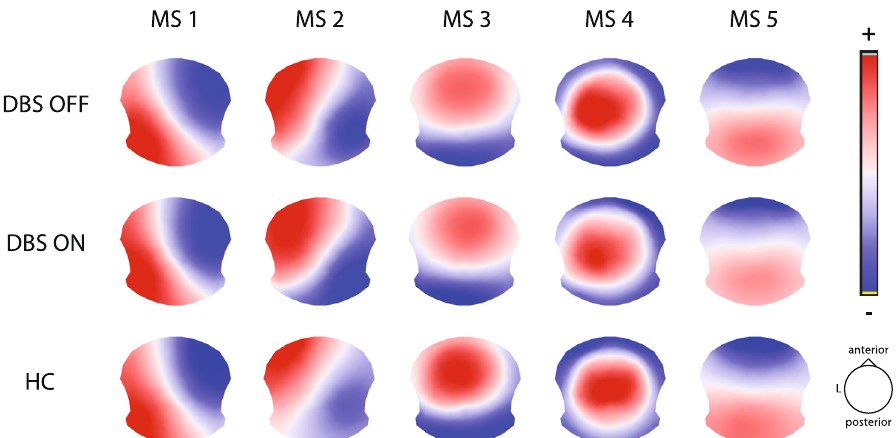
Fig. 1 Topographies of fi ve EEG microstates identi fi ed in each analyzed group. Red color indicates positive electric potential values, blue means negative. Note: the polarity in the topographies can be ignored (oscillations of the same neuronal